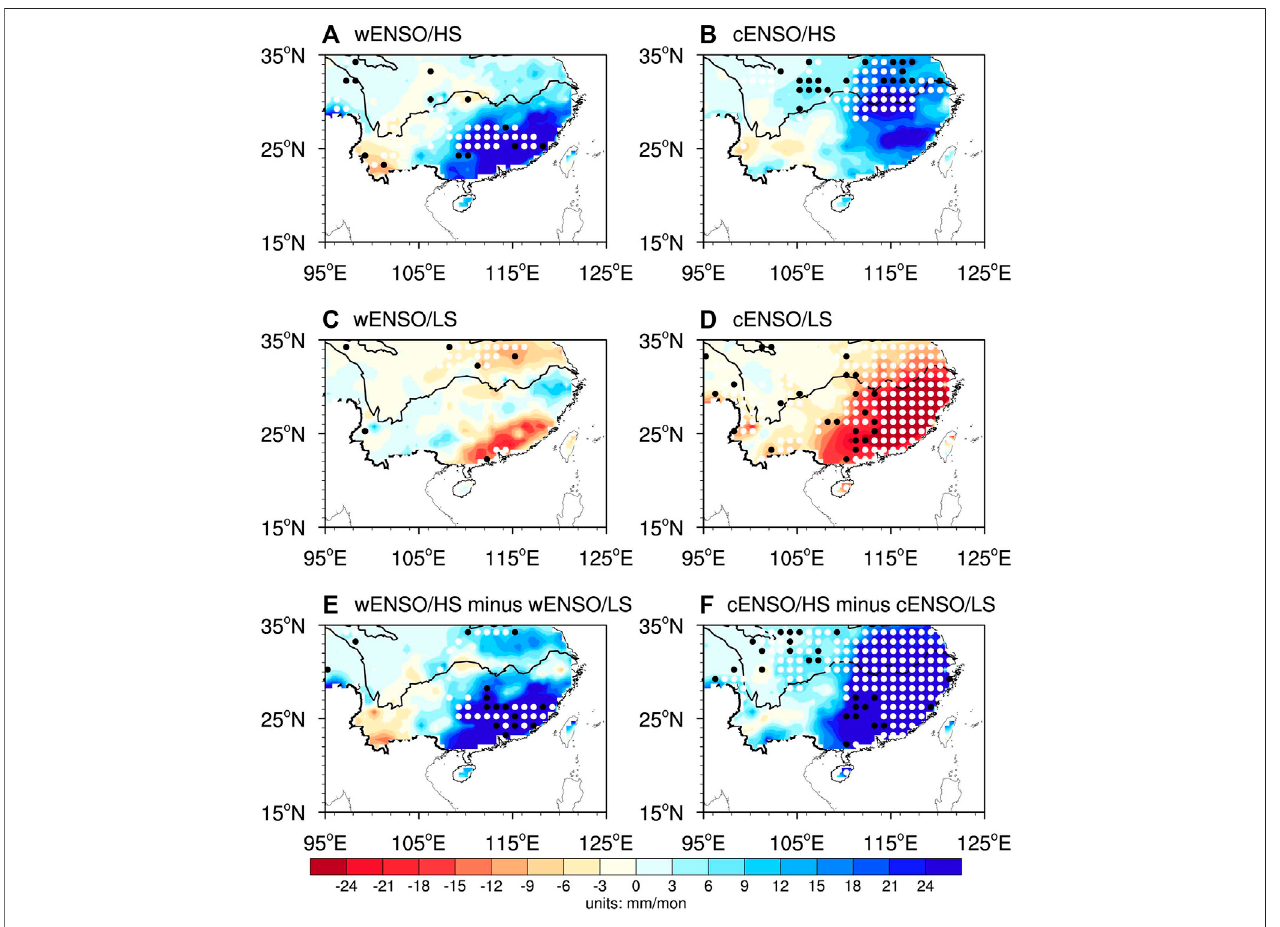
FIGURE 4 | Mid-winter (January) precipitation anomaly (mm/mon) composites of (A) wENSO/HS years, (B) cENSO/HS years, (C) wENSO/LS years and (D) cENSO/LSyears. (E) denotescompositedifferencesbetweenwENSO/HSandwENSO/LSyears. (F) denotescompositedifferencesbetweenwENSO/HSandwENSO/ LS years. Solid black (white) dots denote 90% (95%) con fi dence level. The data used here is monthly land surface precipitation data from the University of Delaware (v5.01) for 1948 – 2016, with a horizontal resolution of 0.5 ° .